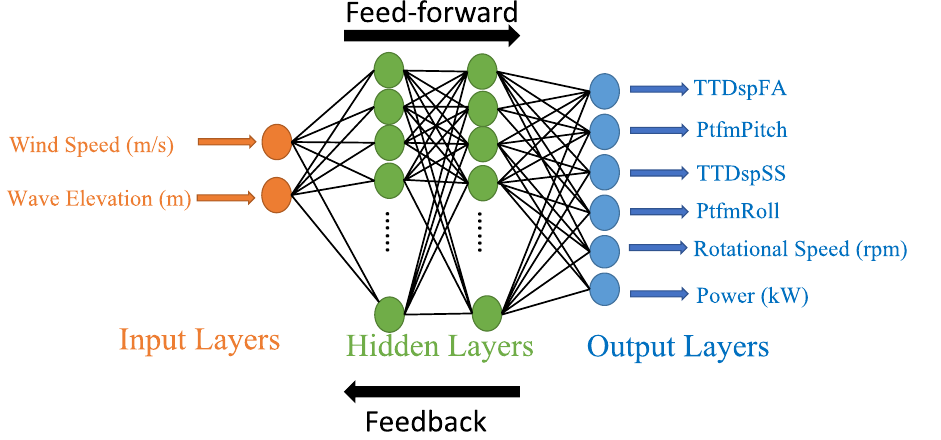
Figure 6. Proposed MLP network for the four OWCs-based barge FOWT system.